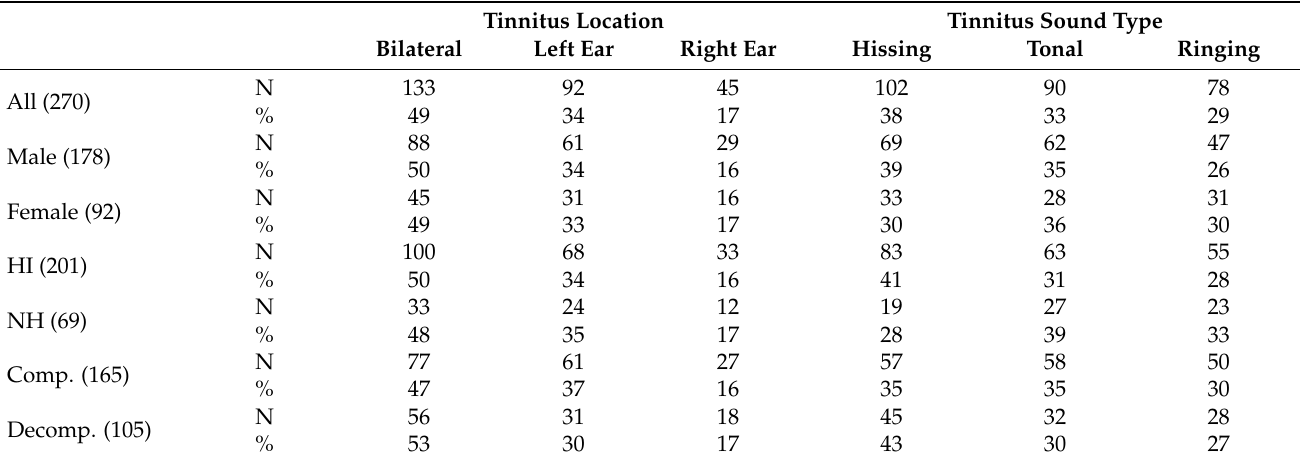
Table 2. Tinnitus location and tinnitus sound type of